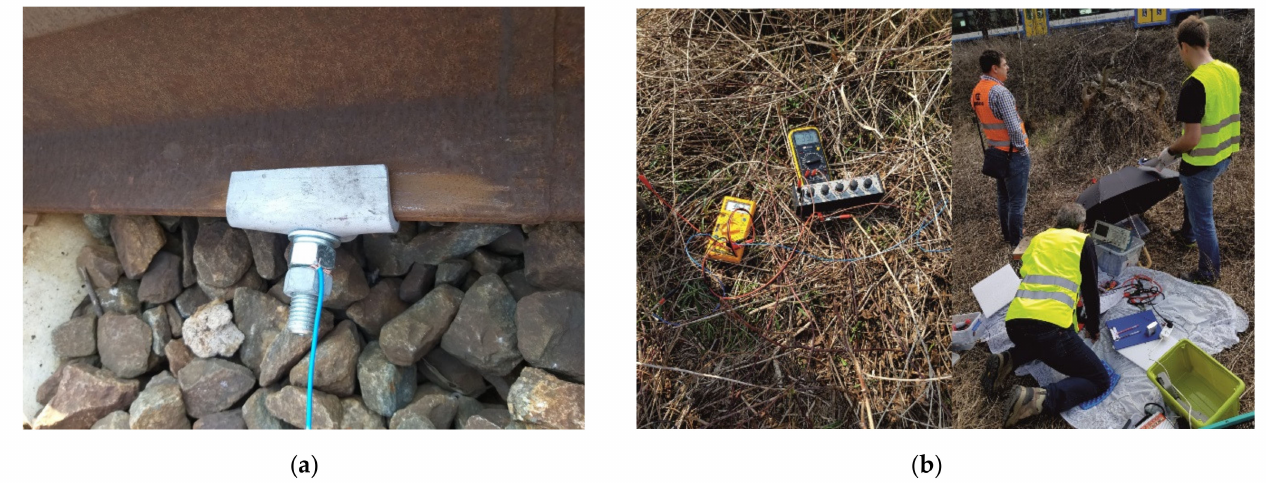
Figure 4. The field survey: ( a ) Connecting the datalogger device to the track with a clamp; ( b ) Measuring the rail potential in the presence of moving